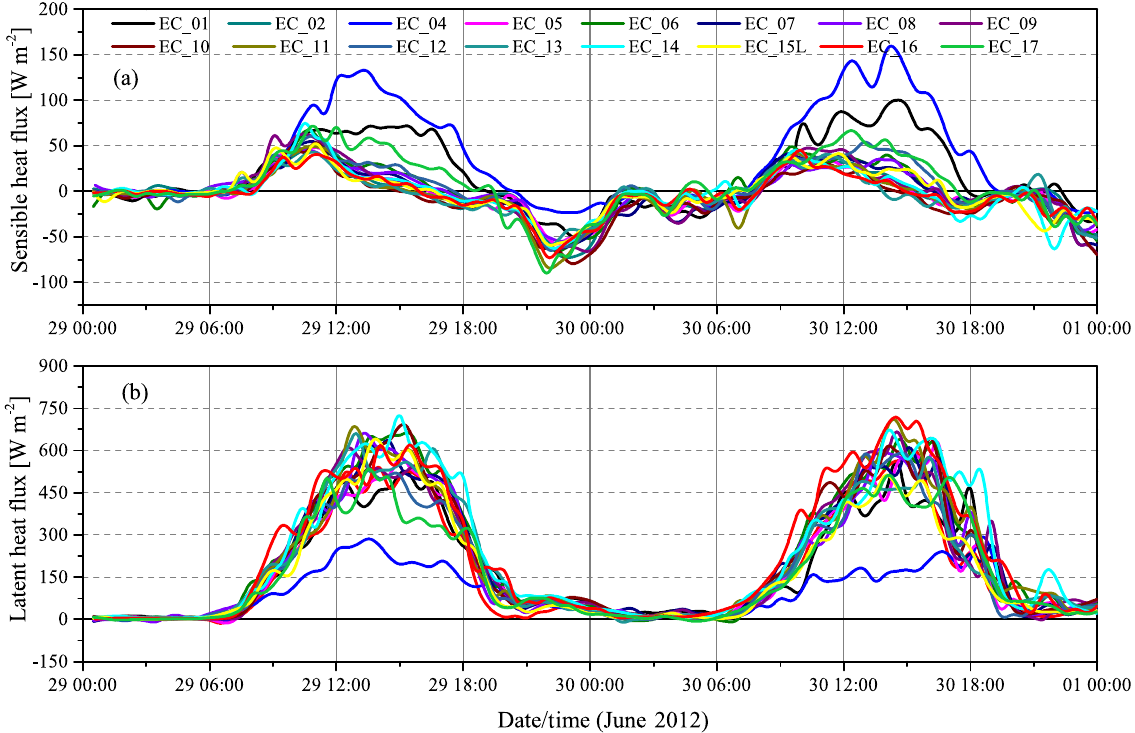
Figure 3. Diurnal cycle of the sensible heat fluxes (a) and latent heat fluxes (b) between different sites during 29 and 30 June